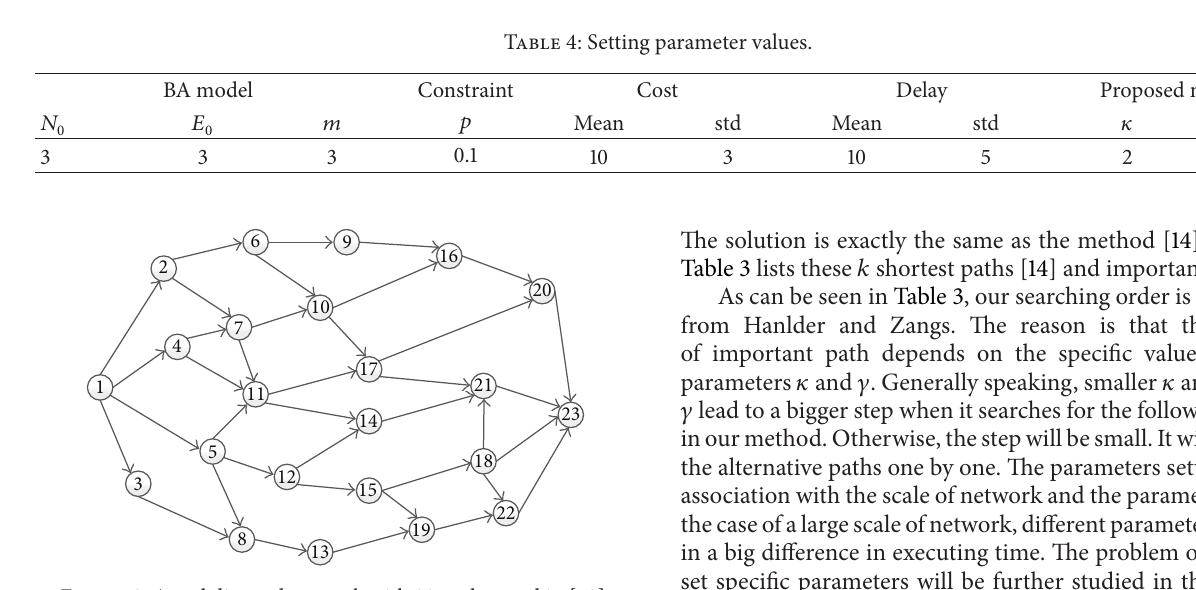
Figure 3: A real directed network with 23 nodes used in